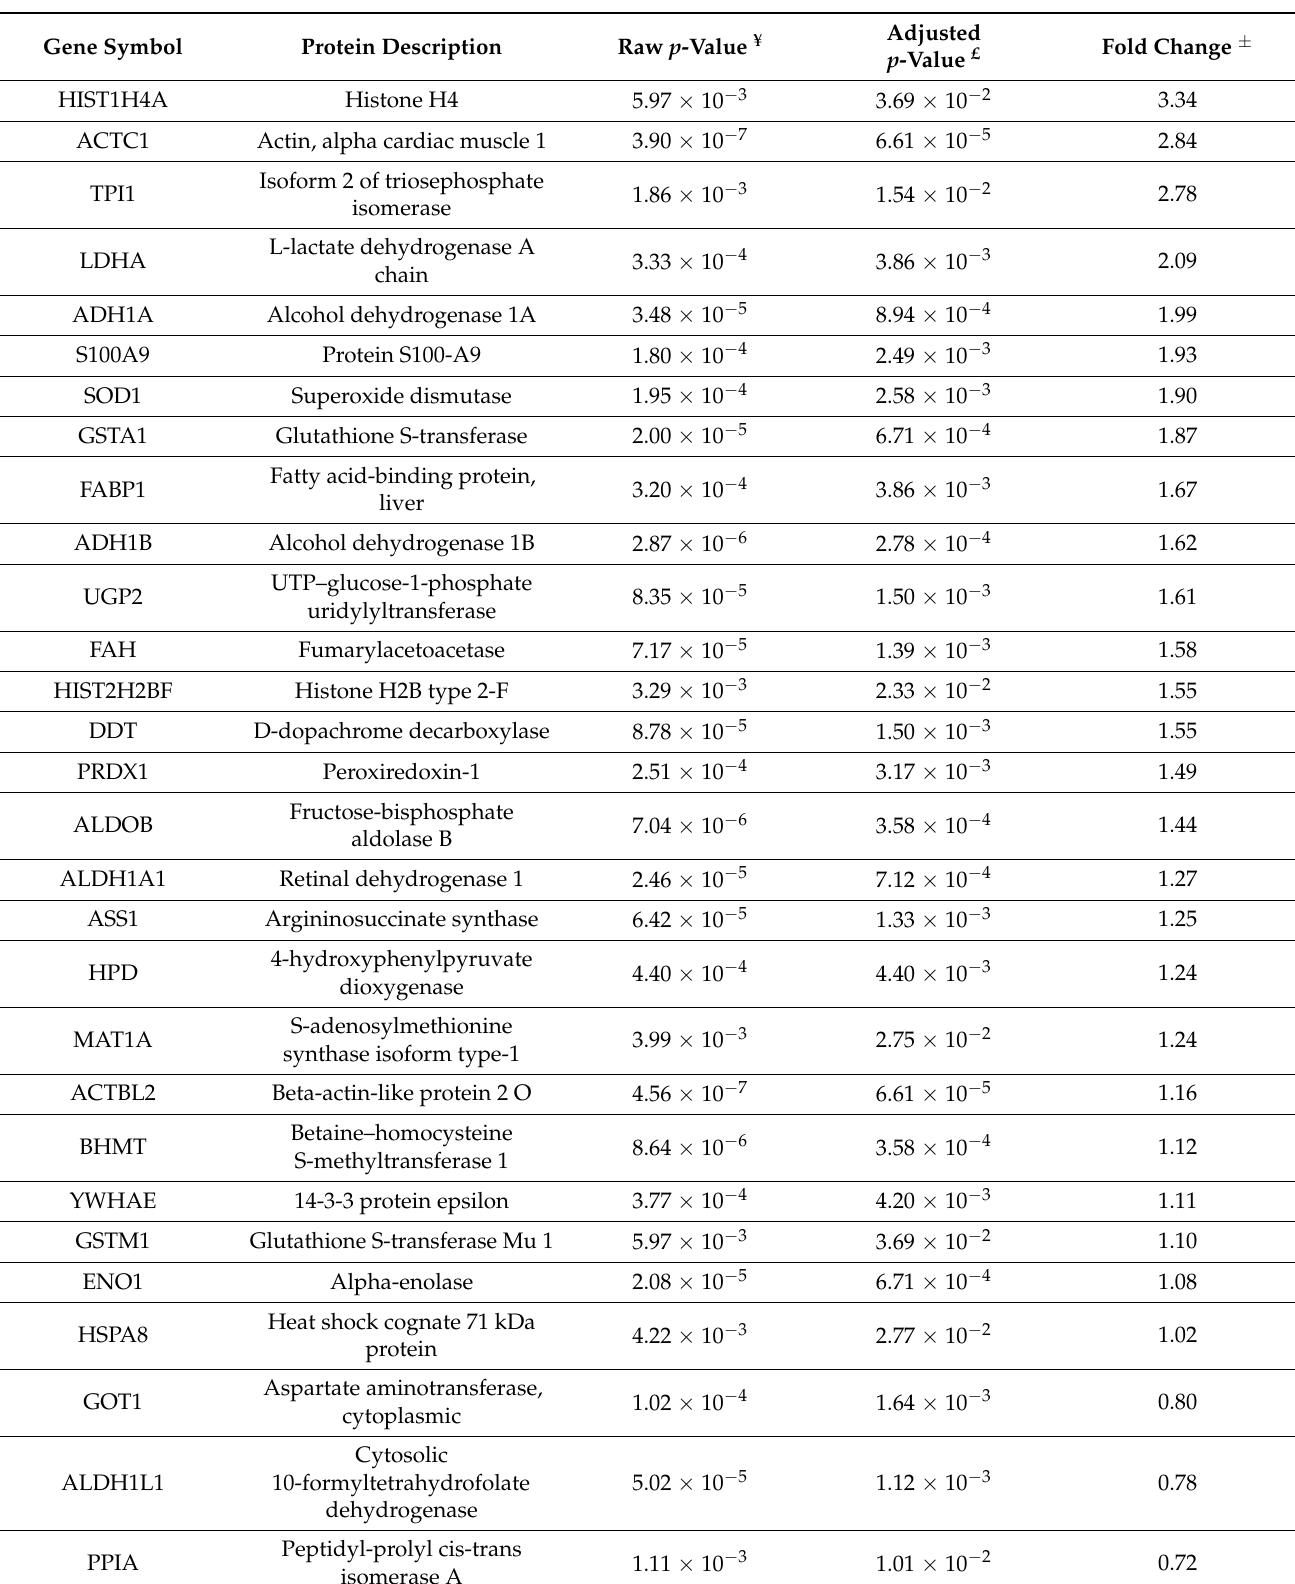
Table 3. Differentially expressed plasma proteins between EoT and non-EoT groups based on adjusted p -value <